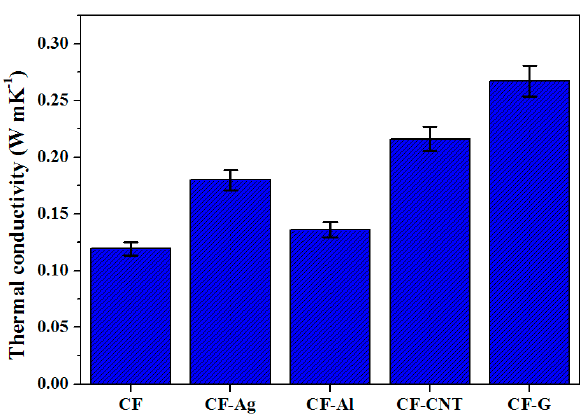
Figure 2. Thermal conductivity of simple carboxymethyl cellulose carbon foam (CF) and CF containing various nano thermal conducting materials.